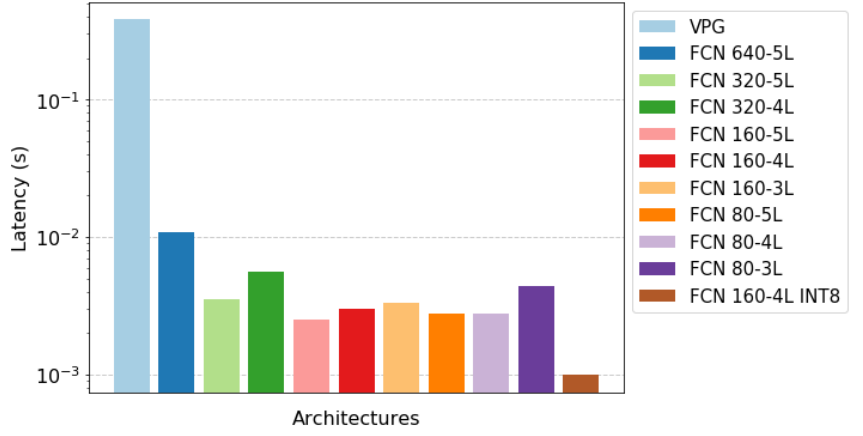
Figure 9. Comparison over forward time of the proposed